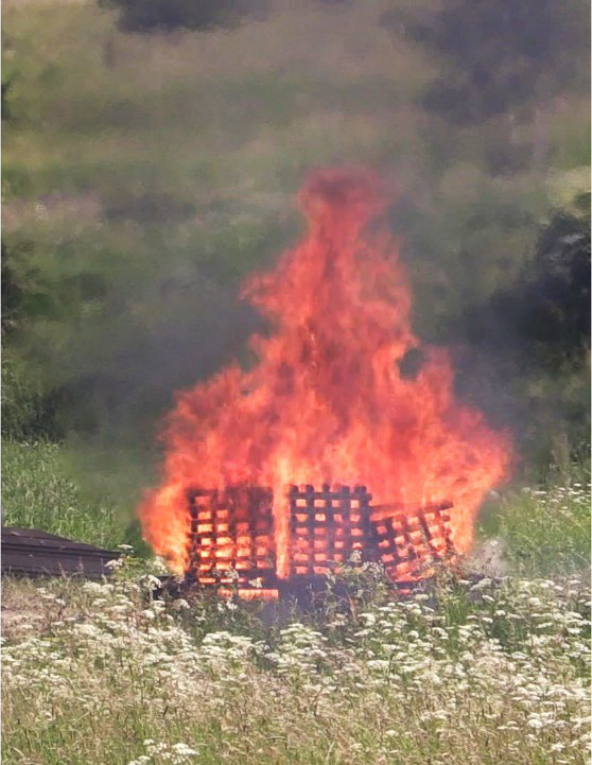
Figure 3. Fully expanded fire around the acetylene cylinder.